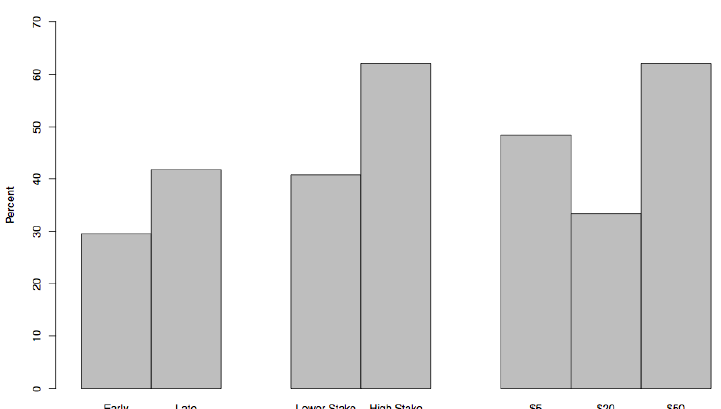
Figure 3. Percentage of grand coalitions forming, by time period and last game stake. The percentages are computed over all sessions. For instance, the bar for “Early” gives the proportion of formed grand coalitions on early games over all possible types of coalitions formed in these